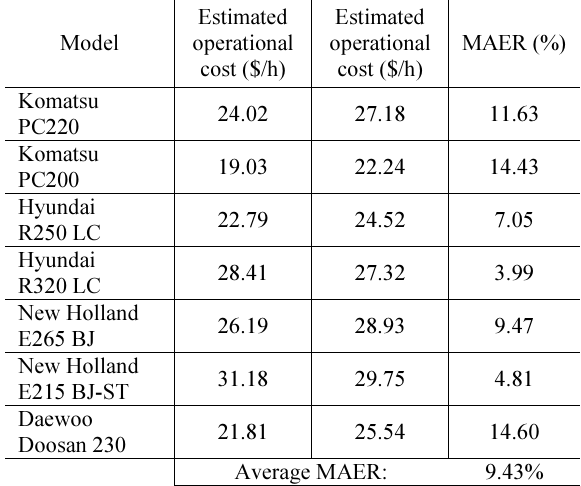
Table 11. Estimated vs. actual operational costs Estimated Model